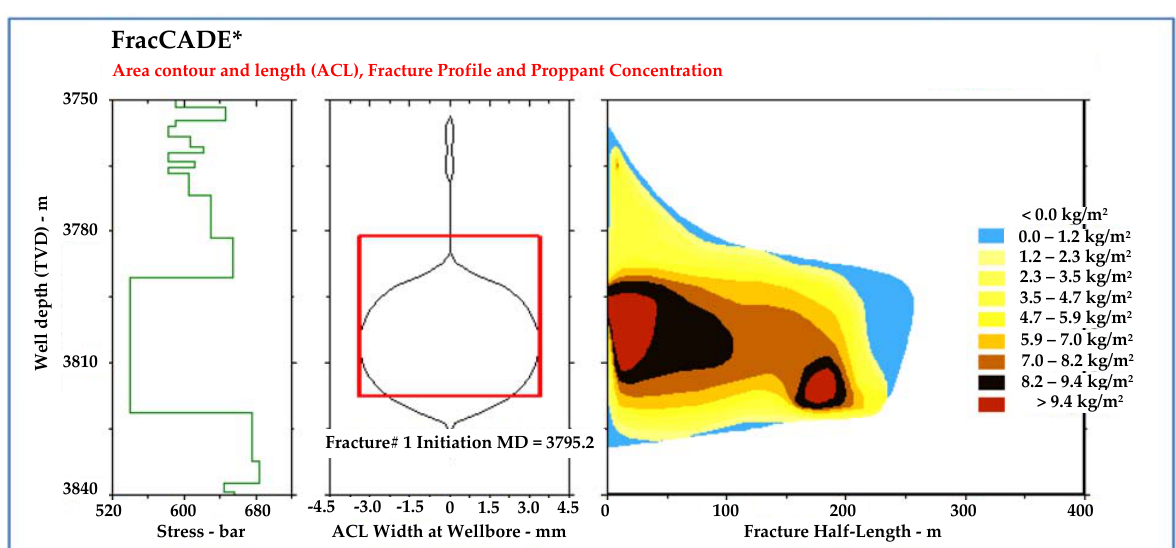
Figure 7. Calibration injection attempt execution [3].